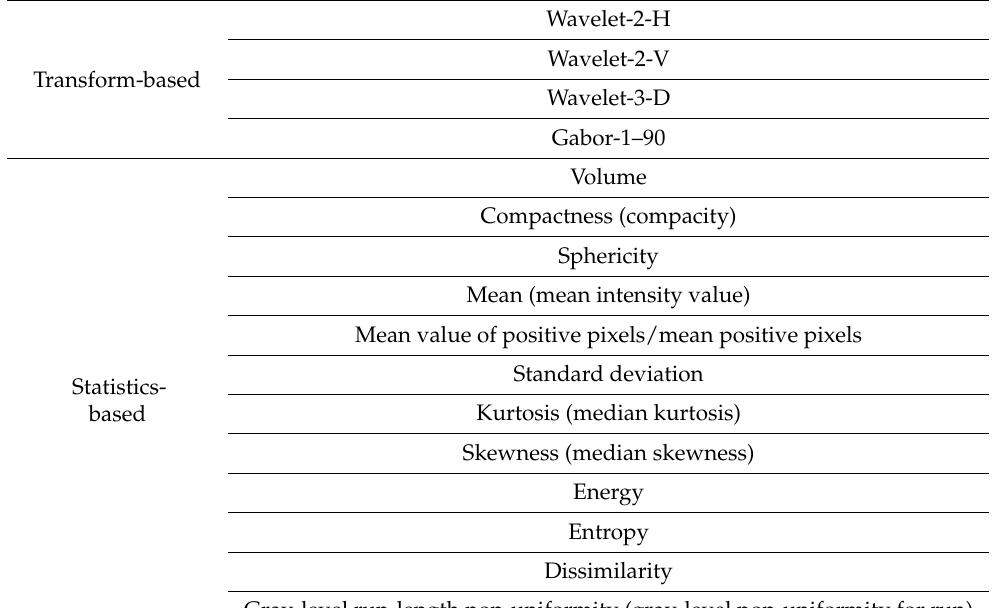
Table 1. AI classification using AI image features.